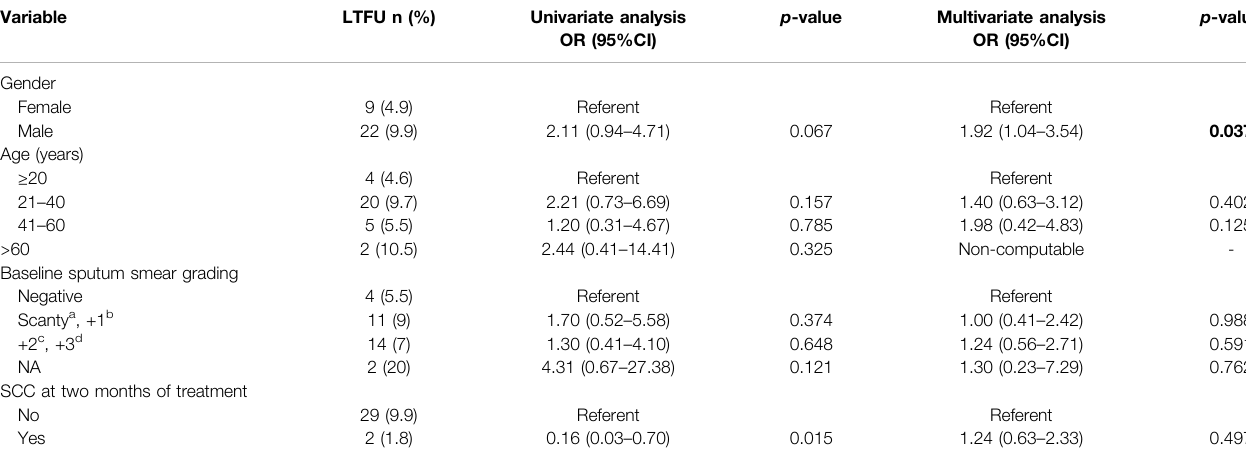
TABLE 4 | Factors associated with lost to